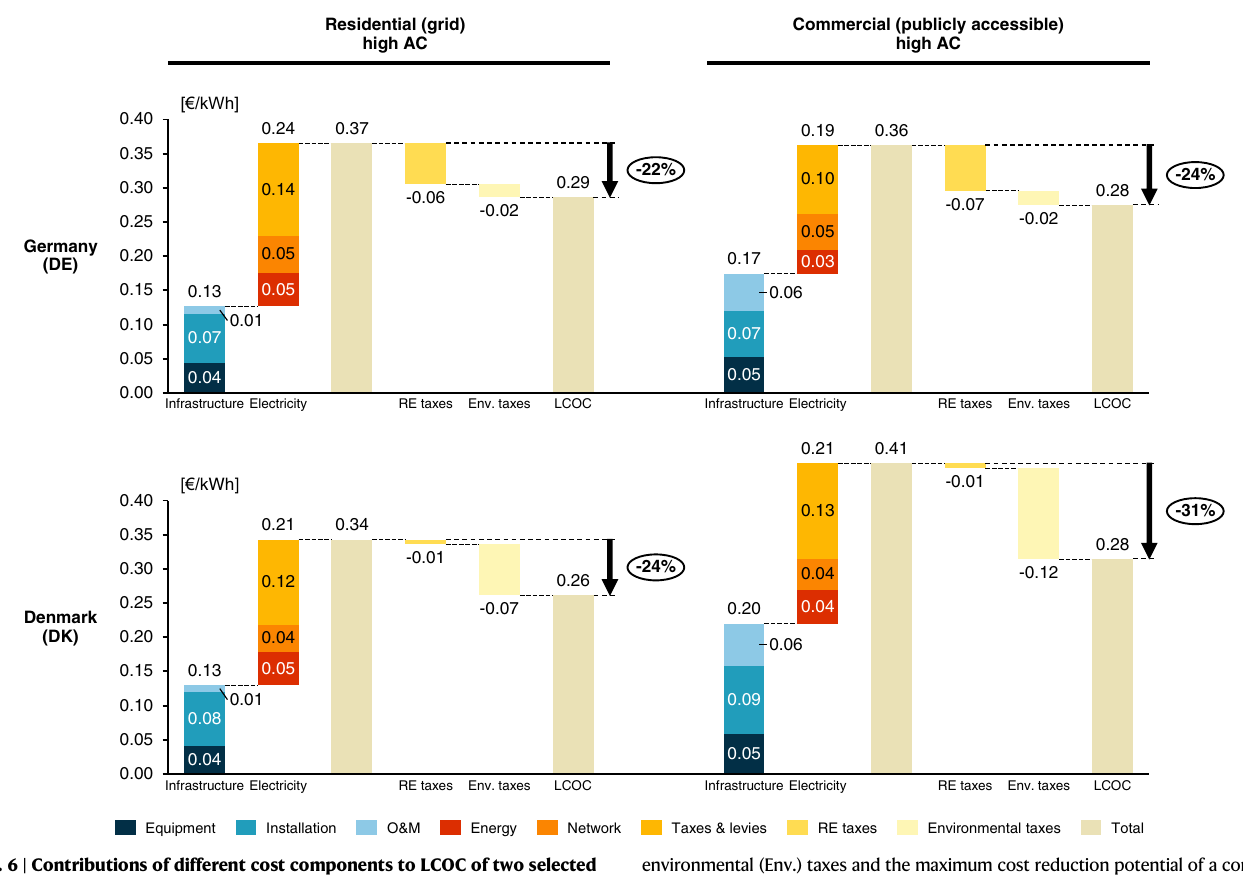
Fig. 6 | Contributions of different cost components to LCOC of two selected charging options in Germany (DE) and Denmark (DK) in € per kWh of energy charged. Additional segments show contributions of renewable energy (RE)